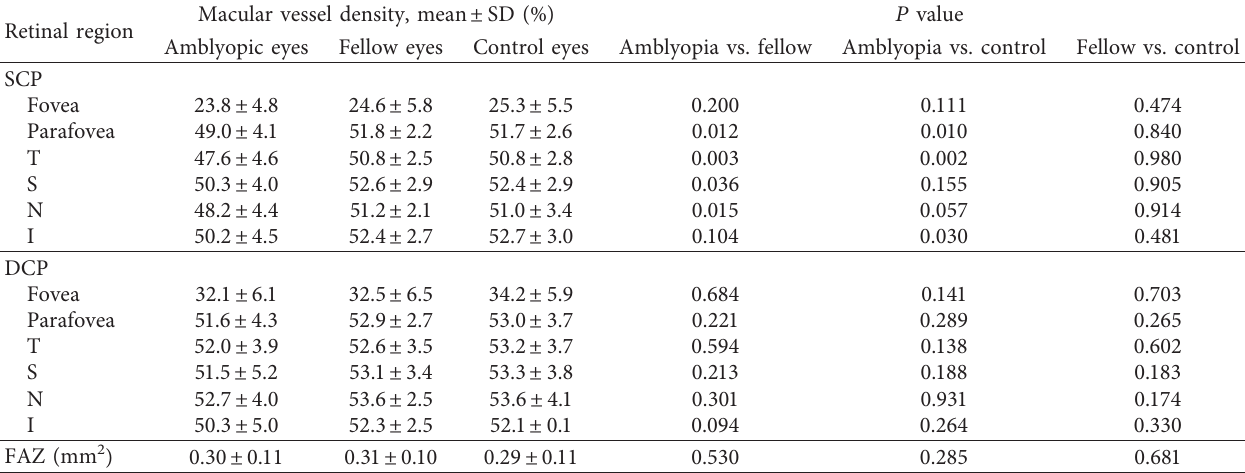
Table 2: Macular vessel density in amblyopic and the normal control group before treatment. Retinal